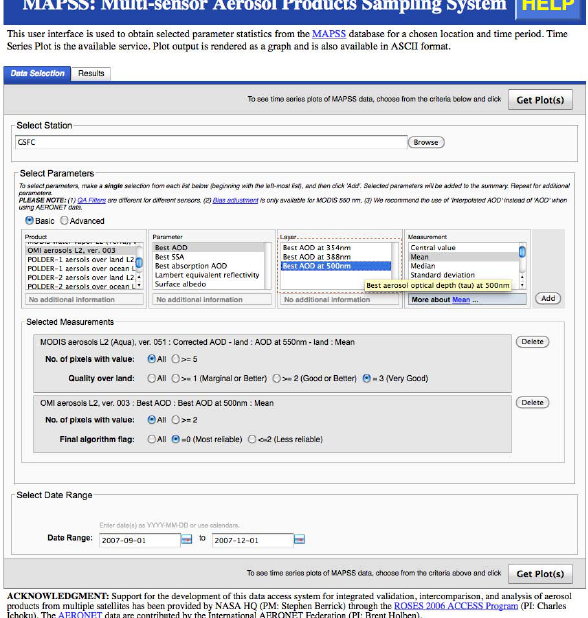
Fig. 6. Web MAPSS data selection interface. In this example, a user has selected GSFC (USA) sampling location. He/she has also se- lected means of two aerosol products (i.e., AOD from MODIS and OMI) and requested to output data only with the best QA flags. The selected time period is from 1 September 2007 to 1 December 2007. A pop-up message displays a summary for the OMI AOD at 500nm data